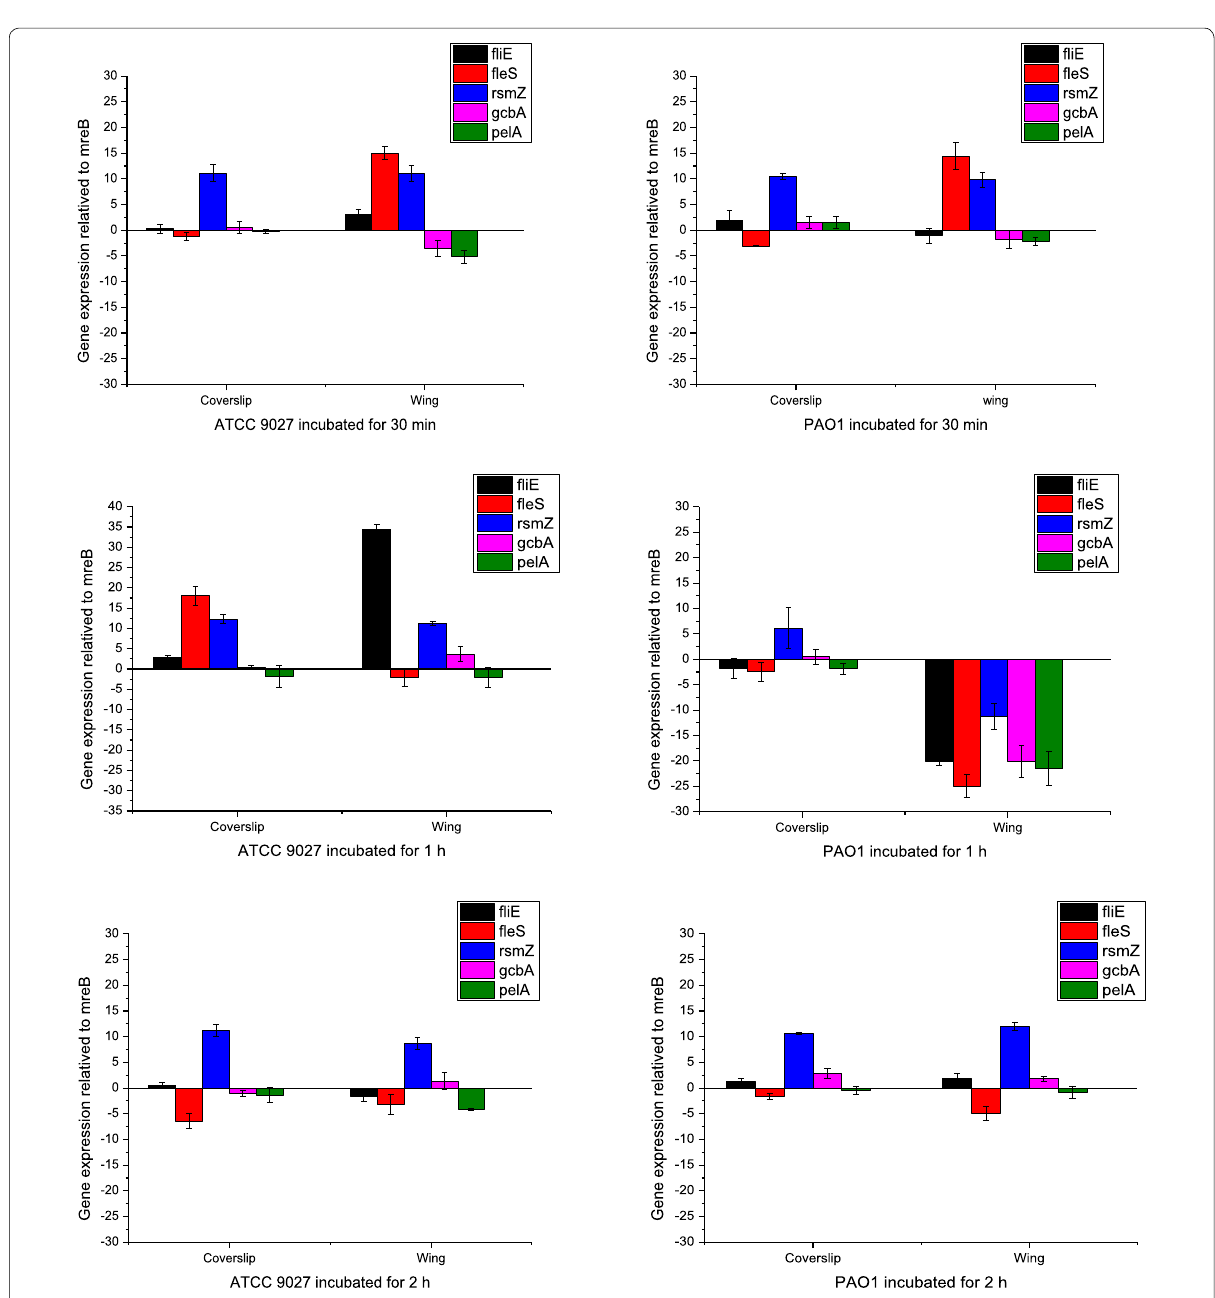
Fig. 5 Transcriptional profile of P. aeruginosa genes that aid in motility (fliE, fleS), reversible to irreversible attachment (gcbA, rsmZ) and EPS synthesis gene (pelA) carried out using RT-PCR. The expressions were relatived to the constitutive actin-homolog